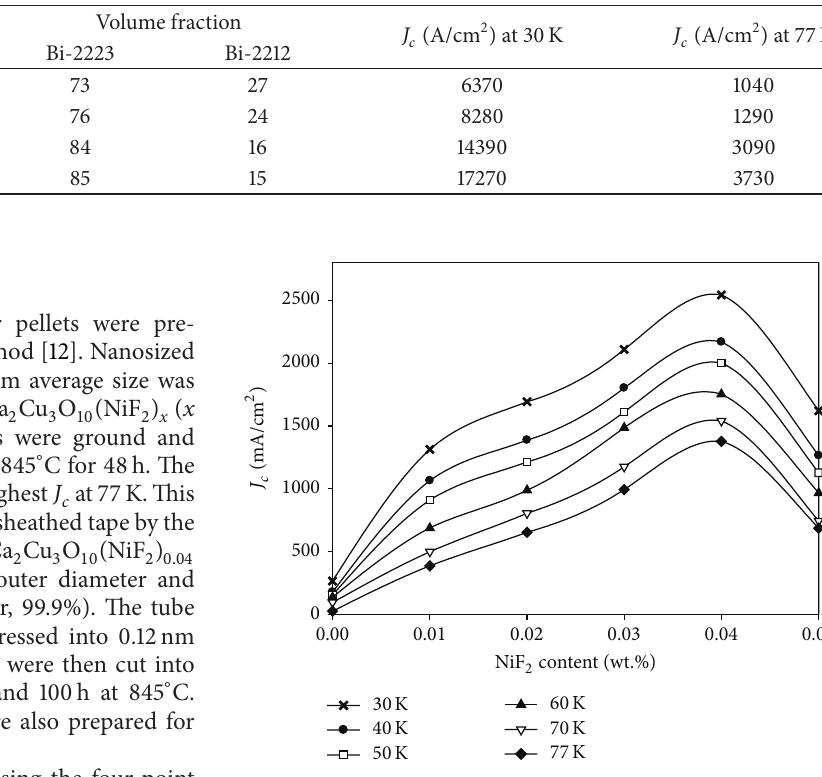
added Bi-2223 tapes sintered 2